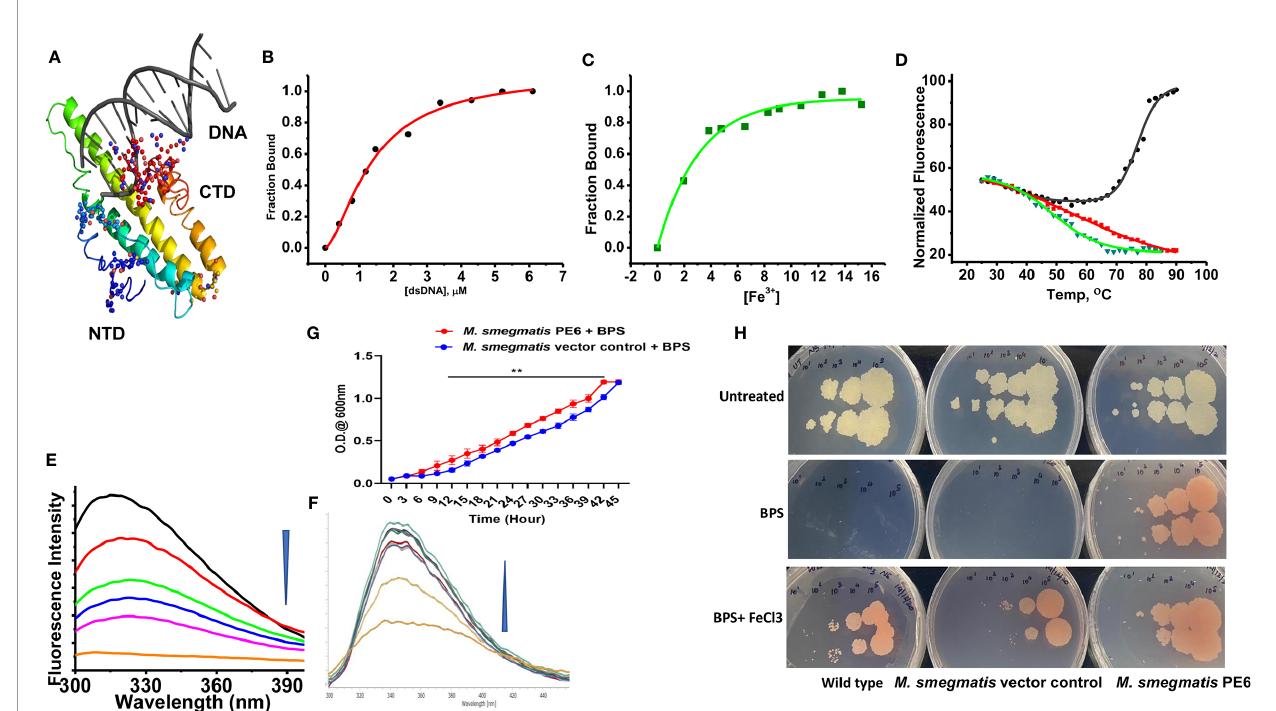
FIGURE 5 | PE6 binds to DNA and iron and M . smegmatis harboring pe6 grown in iron-depleted liquid and solid media. (A) PE6-DNA modeled structure. Putative DNA binding regions are shown as spheres along with N-terminal and C-terminal domains. (B – D) Nonlinear curve fi tting analysis to determine the apparent dissociation constant from titrations of PE6 with (A) dsDNA, (B) Fe. (C) FTS assay to determine the melting temperature (Tm) of PE6 alone (Black) and in the presence of dsDNA (Red) and Fe (Green). (E, F) Changes in fl uorescence emission spectra (300 – 400 nm) upon the titration of (E) dsDNA and (F) Fe against PE6. (G) Growth kinetics of recombinant M. smegmatis harboring pe6 and vector alone transformed cells in liquid broth containing iron chelator. O.D600 nm was taken at different time intervals, as marked in the graph. pe6 containing M. smegmatis grows signi fi cantly faster than vector alone transformed cells. (H) The growth pattern of recombinant M. smegmatis containing pe6 and vector alone transformed cells in solid media with and without iron chelator and supplementation with Fecl3. The upper panel shows the growth pattern of untreated wild-type, vector alone, and pe6 transformed cells, and the middle and the lower panel shows the growth pattern of wild-type M. smegmatis , recombinant M. smegmatis containing pe6 , and vector alone transformed cells in the presence of BPS and BPS + Fecl3. Some 10-fold serial dilutions were plated, and growth was observed on the fourth day after plating. Data were analyzed by two-way ANOVA with Sidak ’ s multiple comparison post-test. Data are representative of three independent experiments. **P < 0.01 vs .